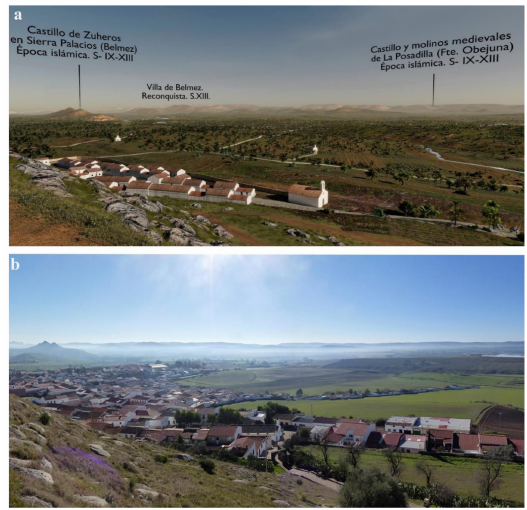
Figure 12. Area surrounding the CCB shown using VR. View to SW: ( a ) medieval landscape; ( b ) current view. Images from Lithodomos VR for “Ager Mellariensis” / AEI FEDER HAR 77136-R.